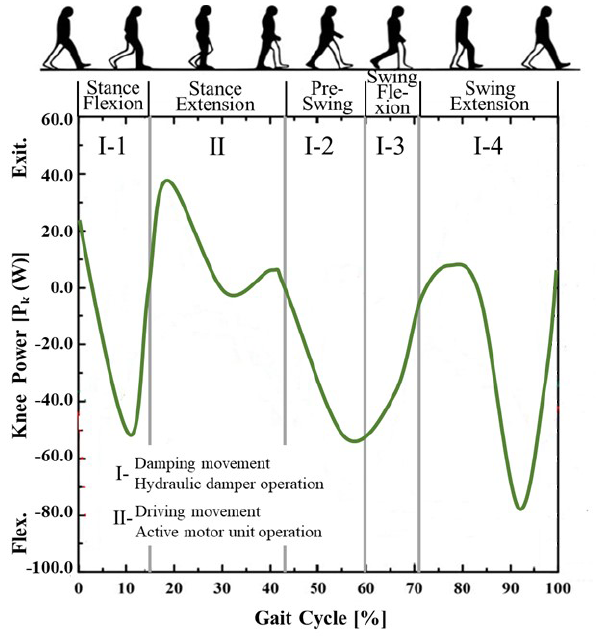
Figure 2. Operating modes of the HPAK when walking on level ground.